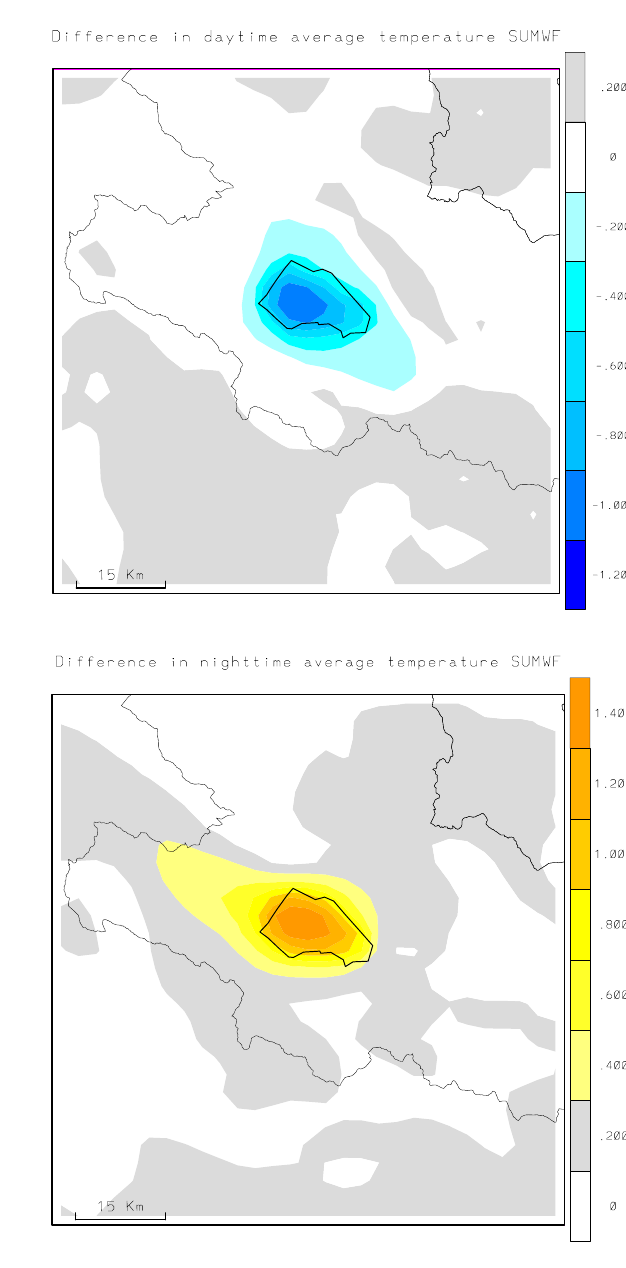
Fig. 8. Same as Fig. 7 but for the summer cases. (a) SUMSF, daytime; (b) SUMWF, daytime; (c) SUMSF, nighttime; (d) SUMWF, nighttime. Units are